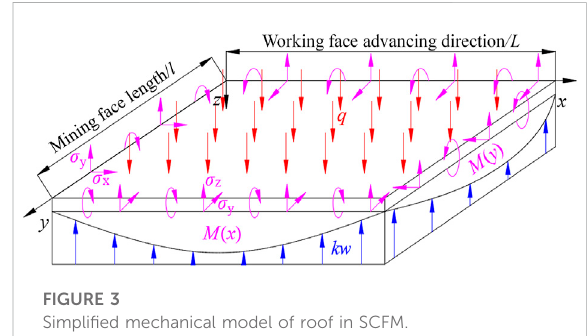
FIGURE 3 Simpli fi ed mechanical model of roof in